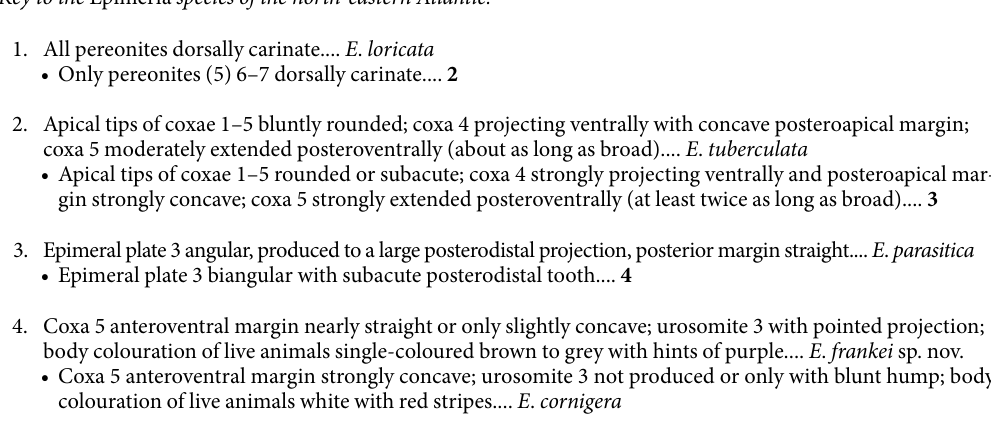
both species with a minimum interspecific distance of 8.69% (K2P) (Table 1). This value is similar to interspecific distances known from other closely related Epimeria species, with minimum distances of 8.5% 59 . Furthermore,